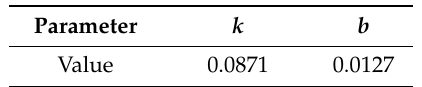
Table 2. Parameters of charging time